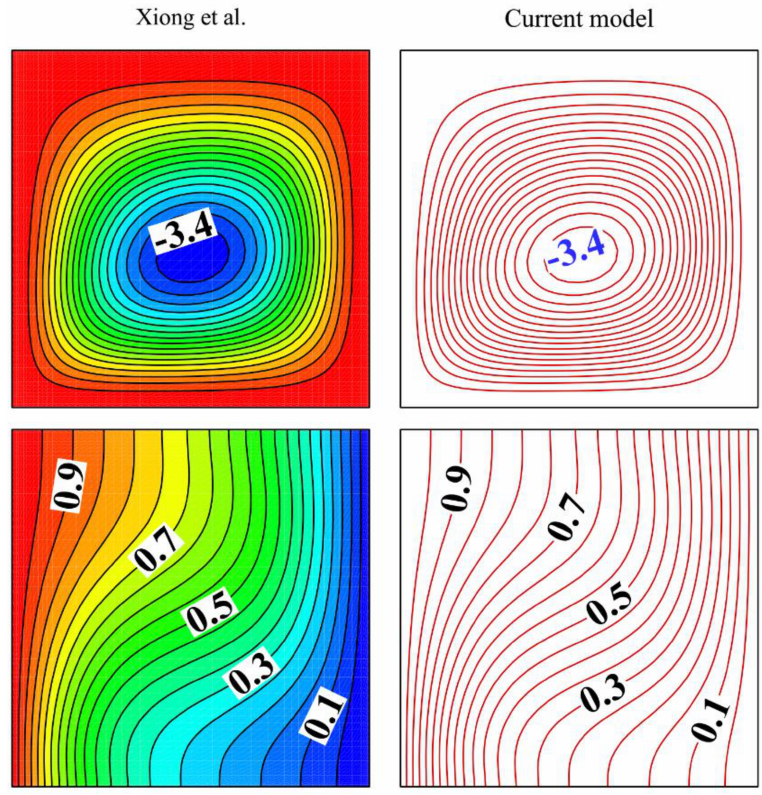
Figure 3. Isotherms and streamlines in an inhomogeneous porous medium of the work conducted by Xiong et al. [32] and the current model.